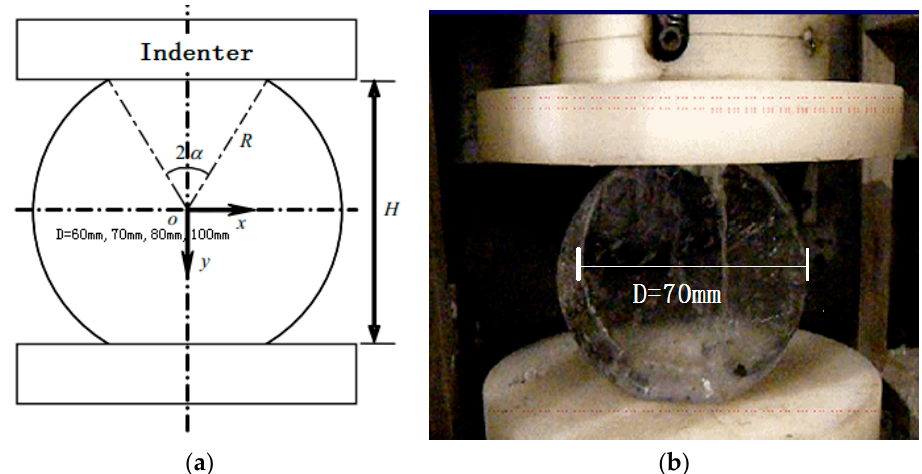
Figure 1. Schematic of Brazilian disc splitting test device. ( a ) The schematic of a sample specimen test. ( b ) The physical test device of Yellow River ice.